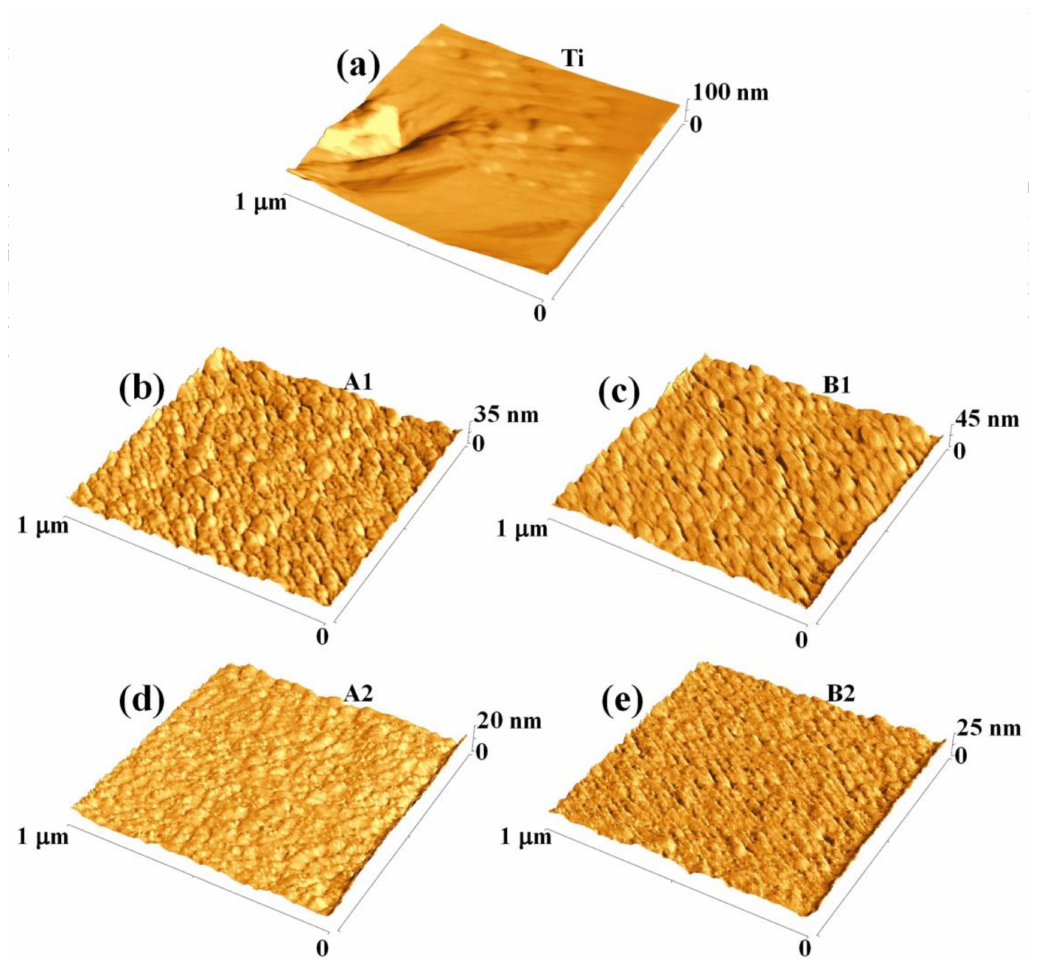
Figure 7. 1 µ m × 1 µ m three-dimensional AFM images of the surface of: ( a ) bare Ti foil; ( b ) thinner (220 nm) Au layer deposited, at θ = 0 ◦ , on Ti foil (sample A1); ( c ) thinner (140 nm) Au layer deposited, at θ = 48 ◦ , on Ti foil (sample B1); ( d ) thicker (350 nm) Au layer deposited, at θ = 0 ◦ , on Ti foil (sample A2); ( e ) thicker (230 nm) Au layer deposited, at θ = 48 ◦ , on Ti foil (sample